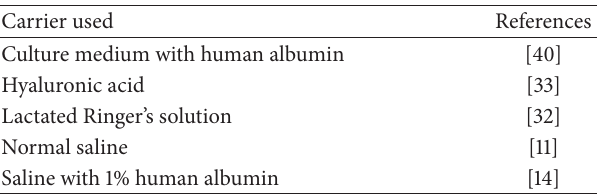
Table 3: Summary of papers that reported human application of ASC according to solution used to resuspend ASCs prior to delivery of cells.